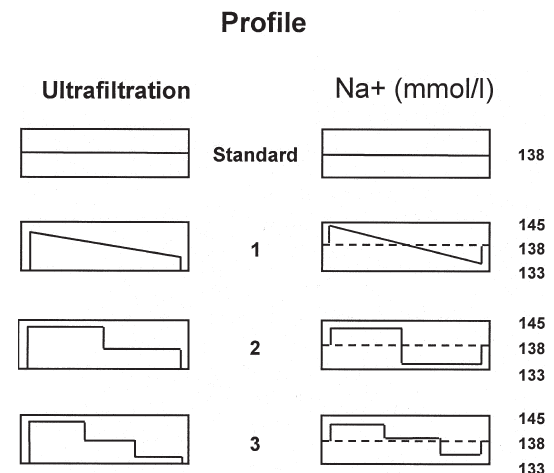
The ultrafiltration and Na concentration profiles applied: pro- file 1 with linearly decreasing ultrafiltra- tion rate and Na con- centration, Profiles 2 and 3 with decreas- ing ultrafiltration rate and Na concentration in 2 or 3 steps